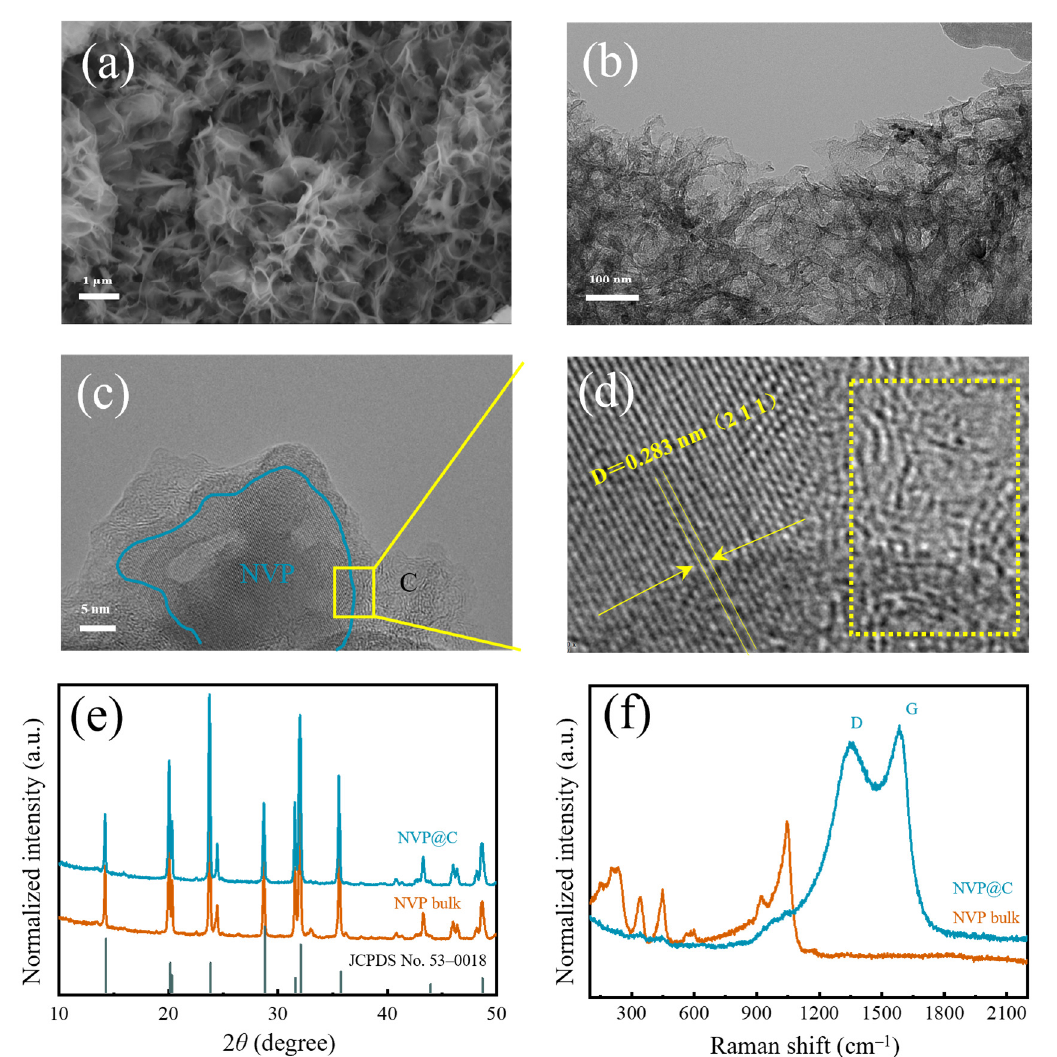
Figure 1. ( a ) SEM image, ( b ) TEM image, ( c ) HRTEM image and ( d ) magnification region (amorphous carbon is marked in the dotted box) of NVP@C; ( e ) XRD patterns and ( f ) Raman spectra of NVP@C and NVP bulk.